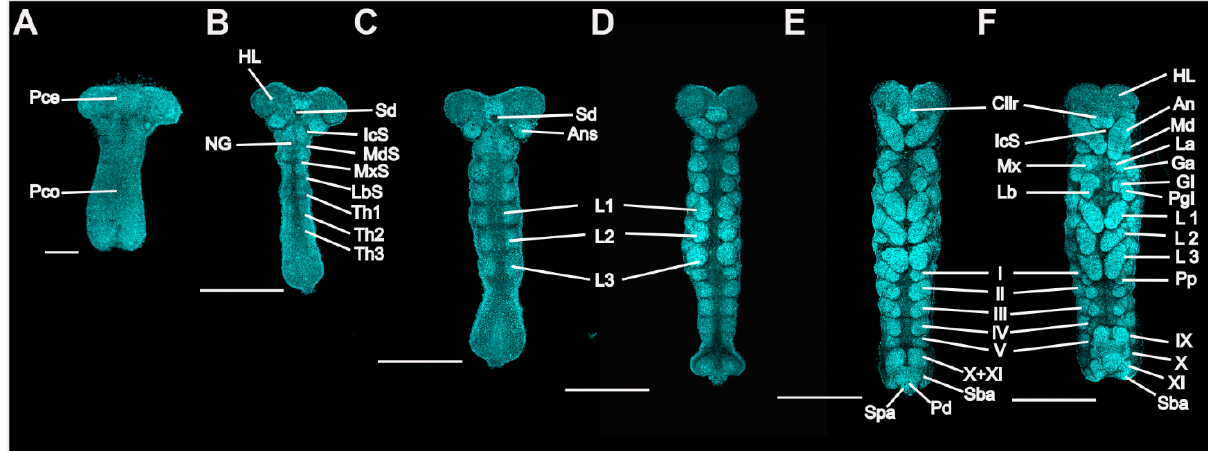
Figure 3. P. americana embryos in stages 3 to 7. Ventral views; the bent embryos were straightened. Fluorescence images with DAPI-stained nuclei are shown. ( A ) Stage 3. ( B ) Early-stage 4. ( C ) Late- stage 4. ( D ) Stage 5. ( E ) Stage 6. ( F ) Stage 7. Scale bars: 200, 500 μ m. An, antenna; AnS, antennal